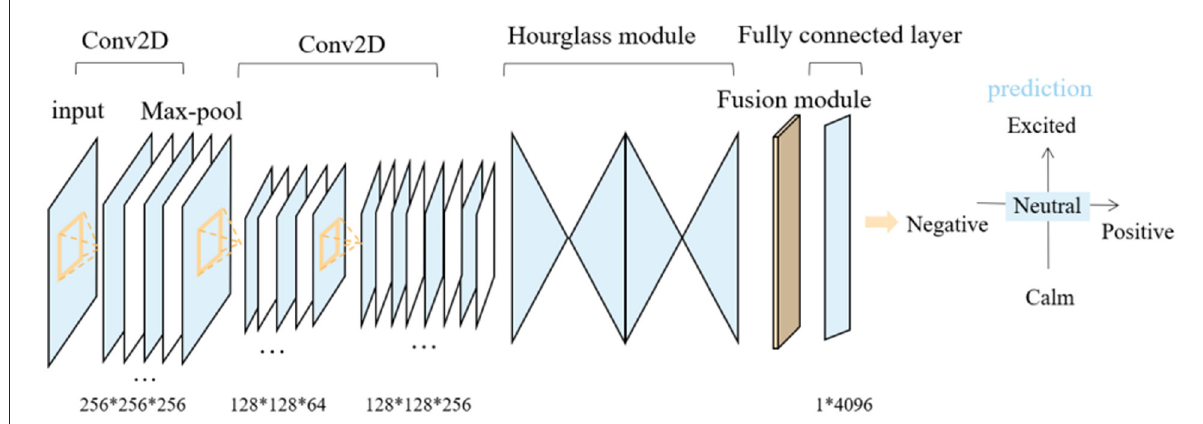
FIGURE2 Recognition of facial expression, arousal and valence. The publication of the information in this figure was agreed to and authorized by the participant.